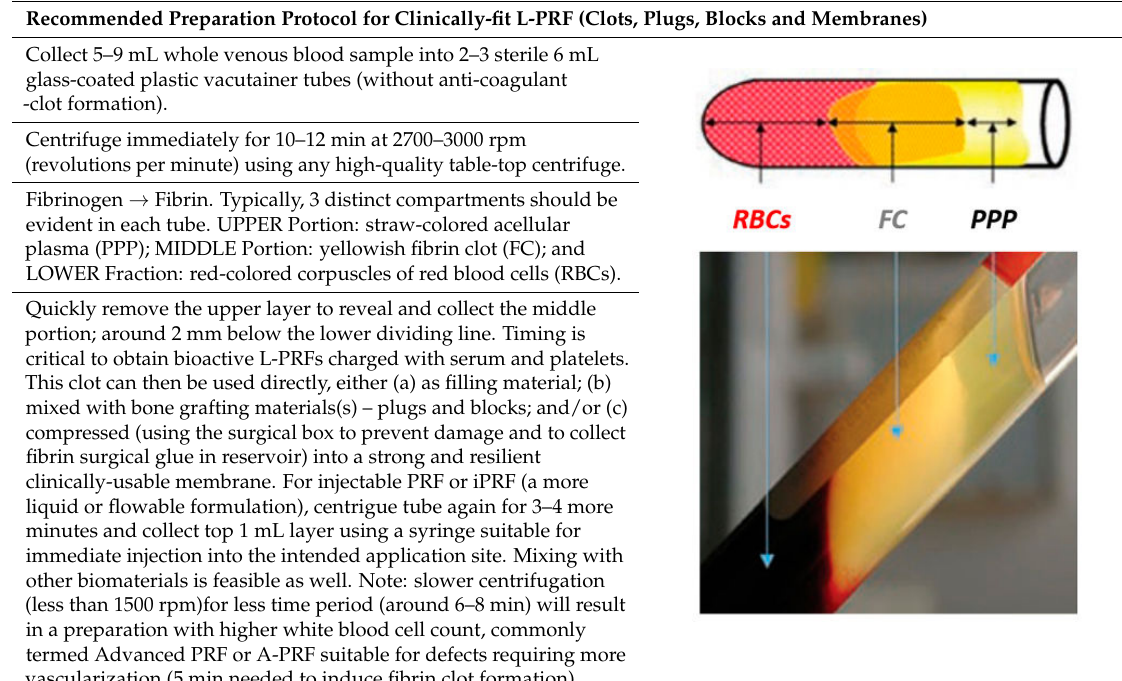
Table 2. Author’s recommendations for L-PRF